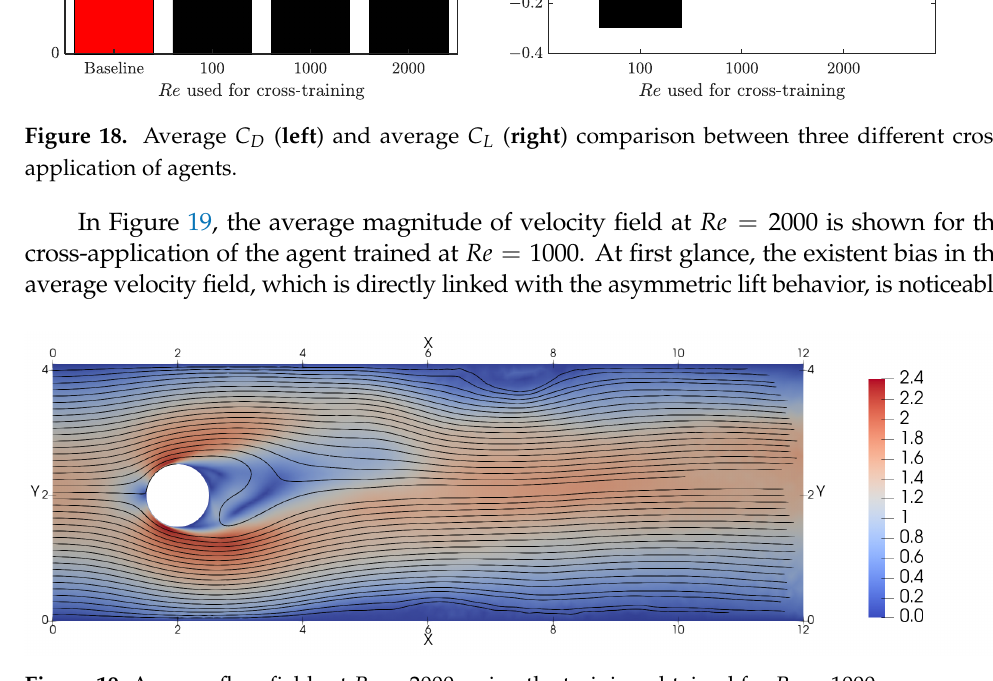
Figure 19. Average flow fields at Re = 2000, using the training obtained for Re =